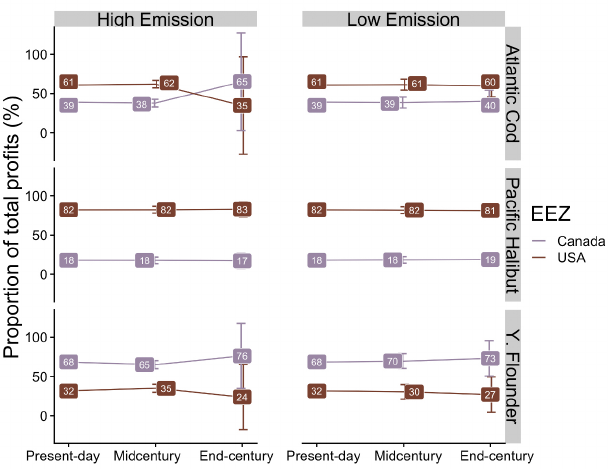
Fig. 3 . Proportion of total profits by country (Canada purple, United States maroon), species, and climate scenario (left panel high emission, right panel low emission). Solid line represents average earth system models (ESM). Error bars represent average ±